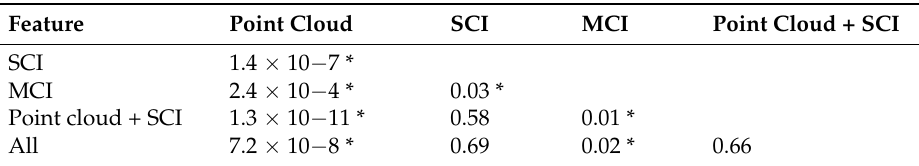
Table 9. McNemar tests on pairs of the classifications using different combination of features. The number in the table is p value. The number with a superscript * indicated that the difference between classifications is significant at a 5% significant